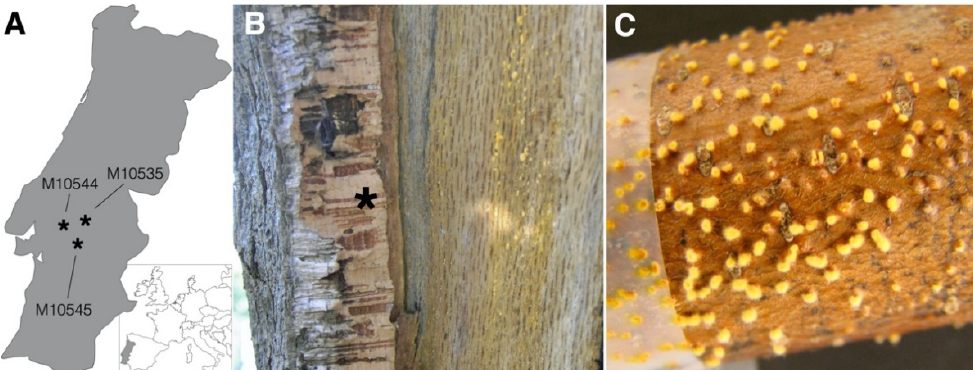
Figure 1. Collection sites and in plant habit of Cryphonectria naterciae . ( A ) Map section of western–central Europe (framed) and magnification of Portugal (gray). Shown are the collection sites of the three specimens analyzed by RNA-seq. ( B ) Removal of the cork bark (asterisk) revealed beneath the yellow to orange mycelium of C. naterciae . ( C ) Small stem segment of the European chestnut inoculated with an agar plug of C. naterciae , showing yellow mycelium breaking through the